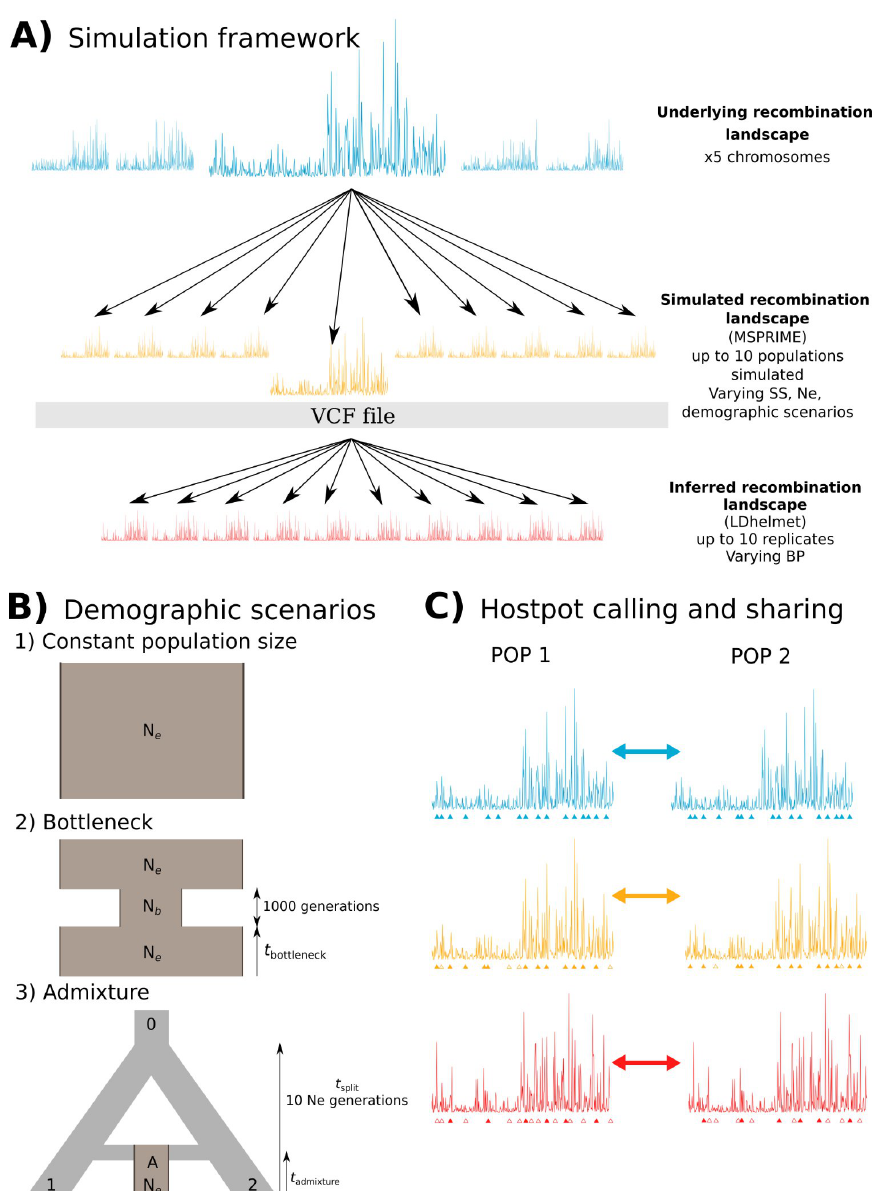
Figure 1 - Simulation and hotspot calling protocols. A) Simulation framework. Five different underlying recombination landscapes were generated based on human empirical data. These five landscapes can either be considered as different regions from distinct chromosomes within a same species, or as orthologous regions of a same chromosome in different species. From these underlying landscapes, up to 10 recombination landscapes were simulated with MSPRIME 0.7.4 under various demographic scenarios, varying the effective population size ( i.e. N e =25,000, 100000, 250,000) and the sample size ( i.e. SS=10, 20), to generate a VCF file for each simulated population. The VCF files were then used to infer the local population recombination rates using LDhelmet 1.19 setting the block penalty to BP = 5, 10 or 50. Up to 10 replicates per simulated population were analysed with LDhelmet. B) Demographic scenarios. Three demographic scenarios were simulated with MSPRIME: 1) Constant population size, varying the N e of the simulated population; 2) Bottleneck event, varying the age of the bottleneck ( i.e. 500, 5000, 50000) and the N e of the population during the bottleneck ( i.e. N b =2500, 25,000), and setting the duration of the bottleneck to 1000 generations; 3) Admixture event, varying the age of the admixture event ( i.e. 500, 5000, 50000), and setting the time of the split of the ancestral population into two populations 10* N e generations ago. C) Hotspot calling and sharing. Hotspots in the underlying (blue), simulated (orange) and inferred (red) landscapes were defined as 2.5 kb-windows with a local recombination rate X times as high as the averaged recombination rate of the 50 kb flanking regions. Several threshold values were used to call the hotspots ( i.e. X =2.5, 5, 10). The location of hotspots was compared between populations (that